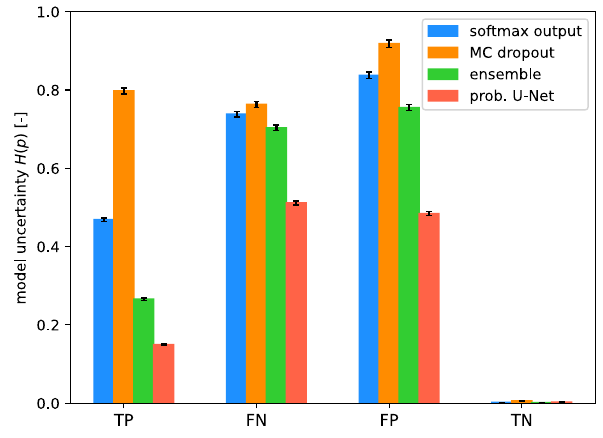
Fig. 9 Uncertainty of the seg- mentation of three compli- cated-shaped defects (dataset 2). For the cutout in the top row, the uncertainties are visu- alized. The red boundary gives the ground truth, and the blue boundary gives the predicted defects, whereby the average of 15 predictions was taken and thresholded by